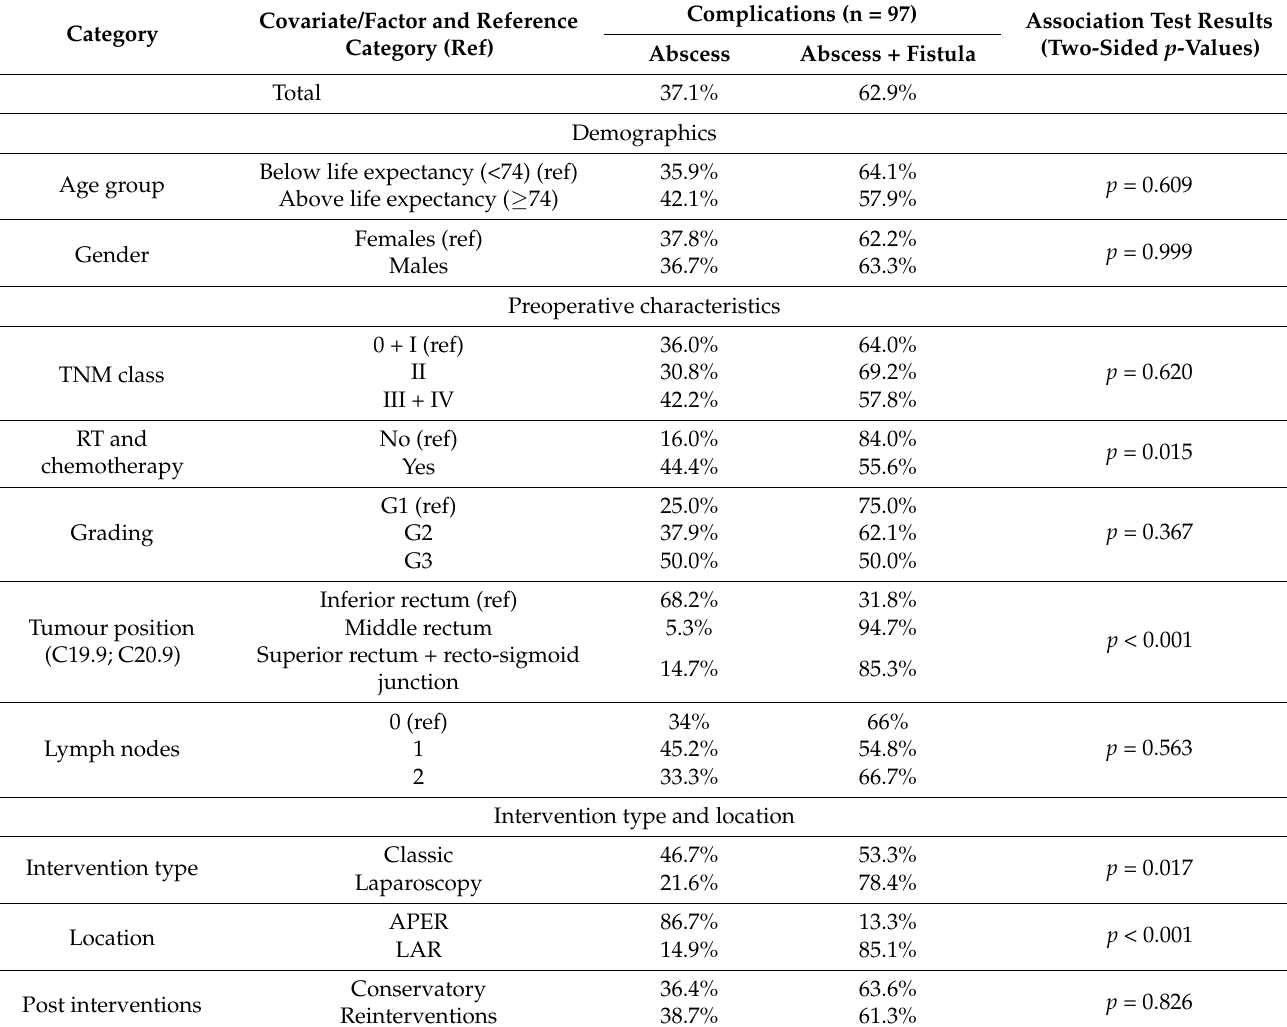
Table 2. The share of complications by type and sample